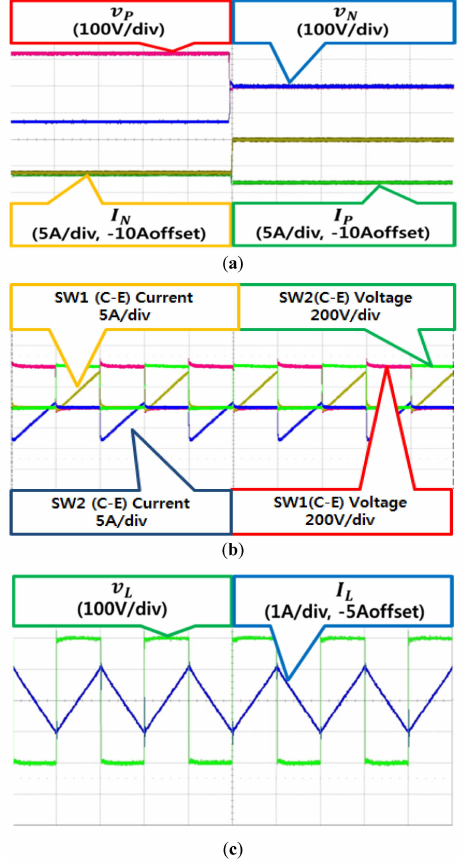
Figure 11. Experimental results of half-bridge voltage balancer with proposed controller: ( a ) Load voltage and current; ( b ) Switch voltage and current; ( c ) Inductor voltage and current.